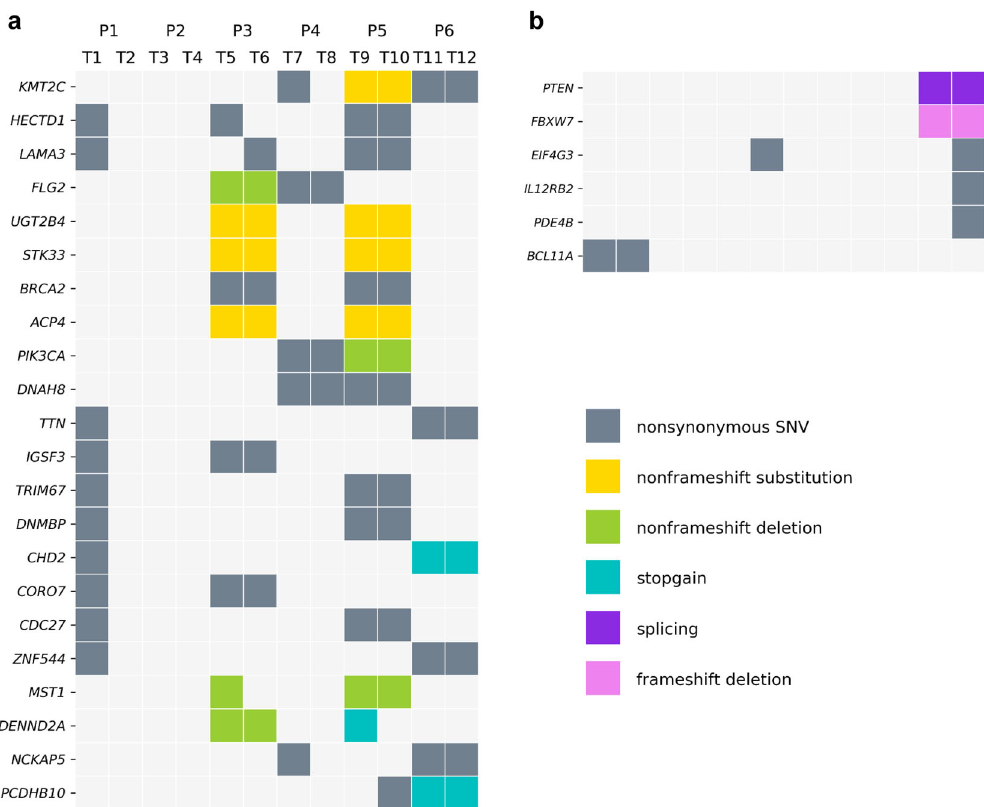
Fig. 1 Somatic mutation pro fi le for 12 tumor samples of six patients. a The most frequently mutated genes are shown in a heatmap, with the columns representing the 12 tumor samples from six patients, and the rows representing genes. The different colors indicate the type of mutation as indicated in the fi gure. b Heatmap of mutations in selected genes known to be involved in cancer pathogenesis or Table 2. The samples from P2 were obtained from an incisional biopsy, which limited the volume of tissue obtained, and these samples were subsequently found to be insuf fi cient for conduct- ing subclone identi fi cation.